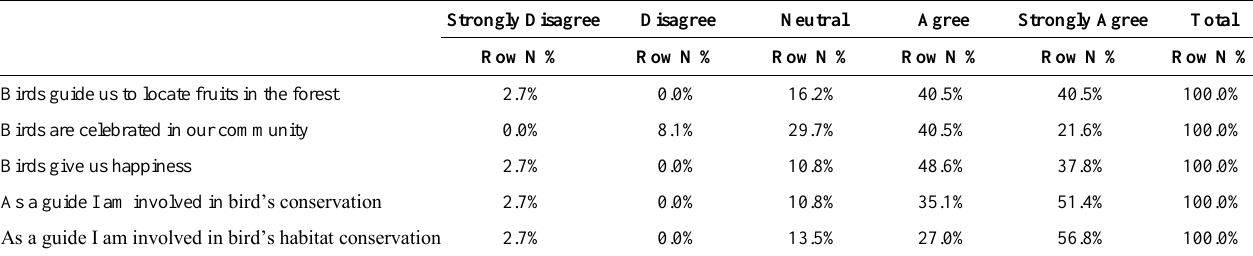
Table 5 . Avitourism guides and